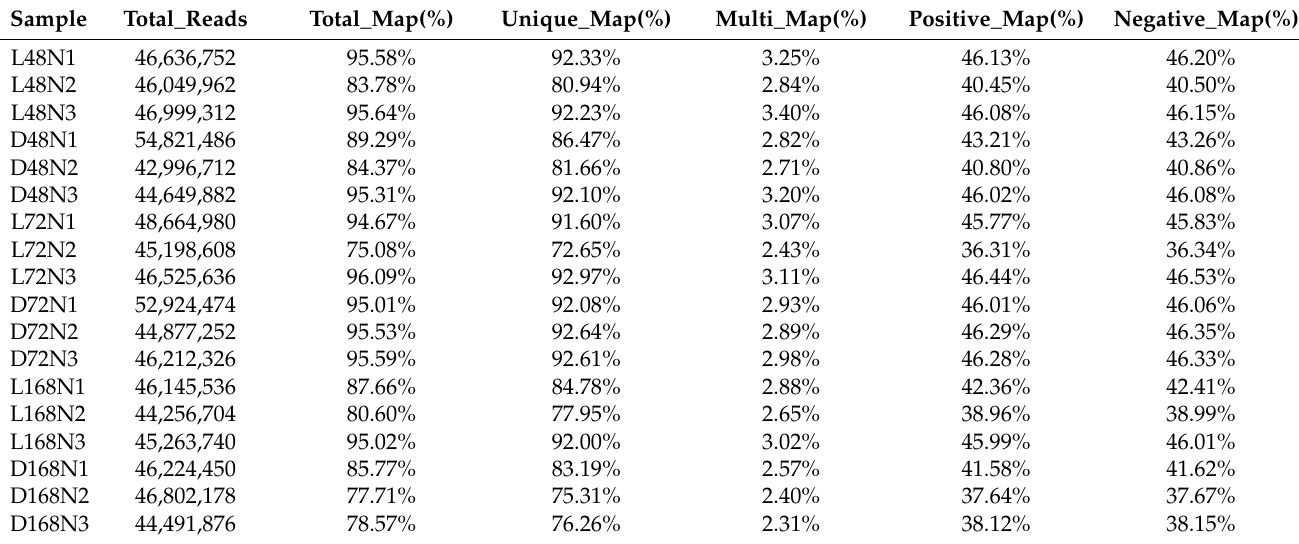
Table 2. Reads of strand-specific RNA libraries and reference genome comparison